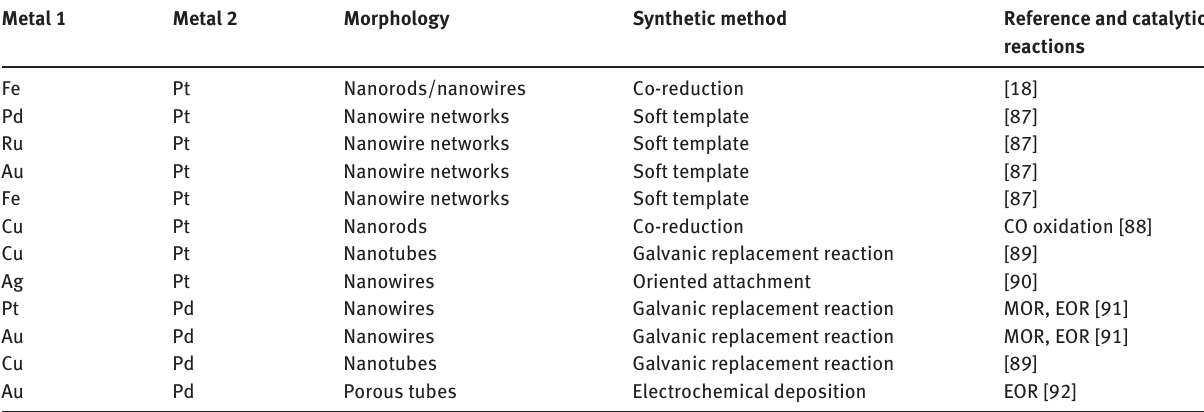
Table 4 List of one-dimensional Pt- and Pd-based bimetallic nanostructures, their synthetic methods, and catalytic reactions. Metal 1 Metal